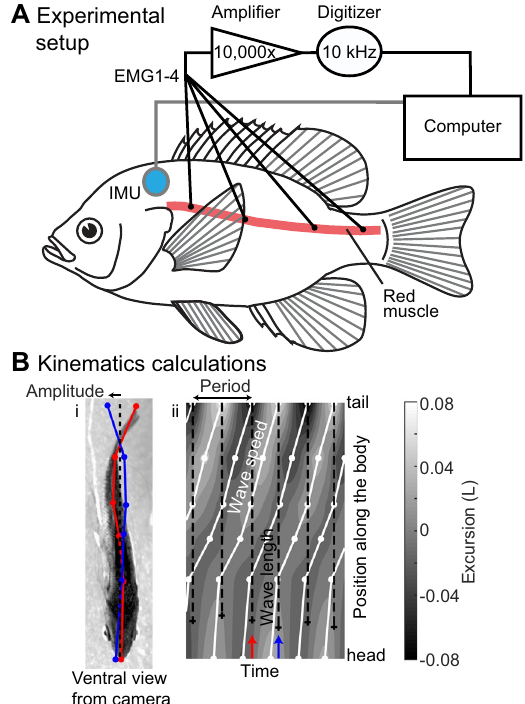
Figure 5. Experimental setup and swimming kinematics calculations. ( A ) Schematic representation of electromyographic apparatus used to record EMGs, showing longitudinal positions of the electrodes (four on each side), and the IMU apparatus used to record acceleration and its placement on fish. ( B ) Schematic of kinematics calculations. The left panel (i) shows one frame from ventral video, showing the digitized midline points (in red) and points from one half tail beat later (in blue). The right panel (ii) shows excursion of the body in gray, with peak excursion at each body position shown with connected white lines, and the body wavelength shown with a dashed line. Blue and red arrows indicate the time of the frames shown in panel B. See text for details of the